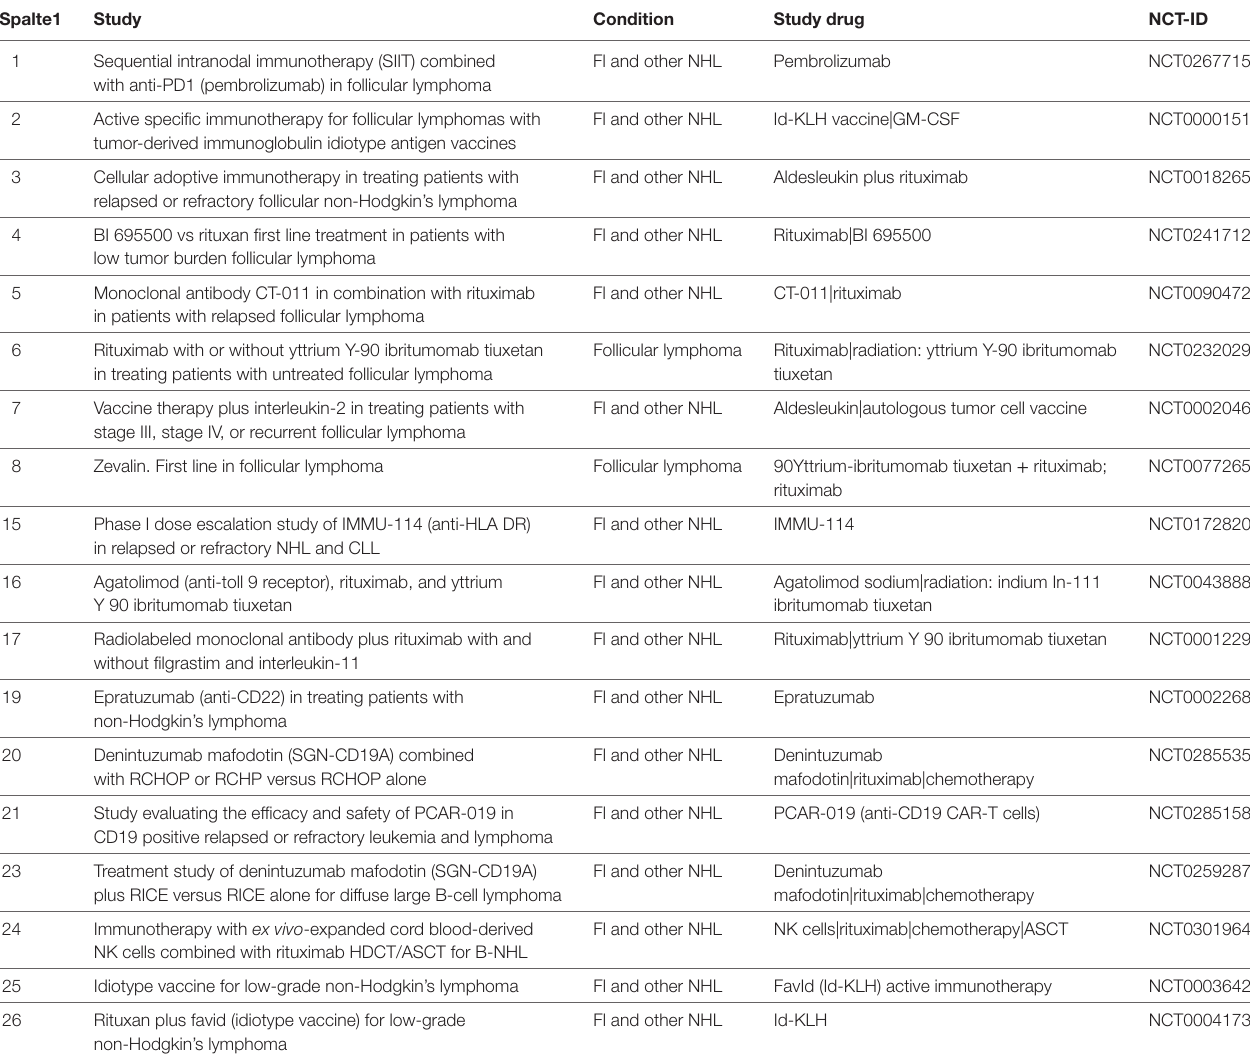
TABLe 1 | Ongoing trials in follicular lymphoma (FL) with immune interventions on clinical.trials.gov. Spalte1 Study Condition Study drug NCT-iD Sequential intranodal immunotherapy (SIIT) combined Fl and other NHL with anti-PD1 (pembrolizumab) in follicular lymphoma Active specific immunotherapy for follicular lymphomas with tumor-derived immunoglobulin idiotype antigen